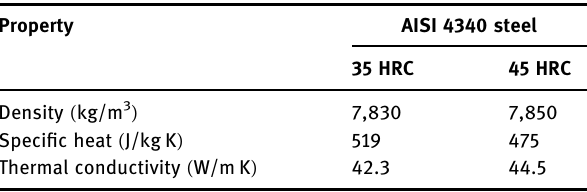
Table 5: Mechanical and thermal properties of hardened AISI